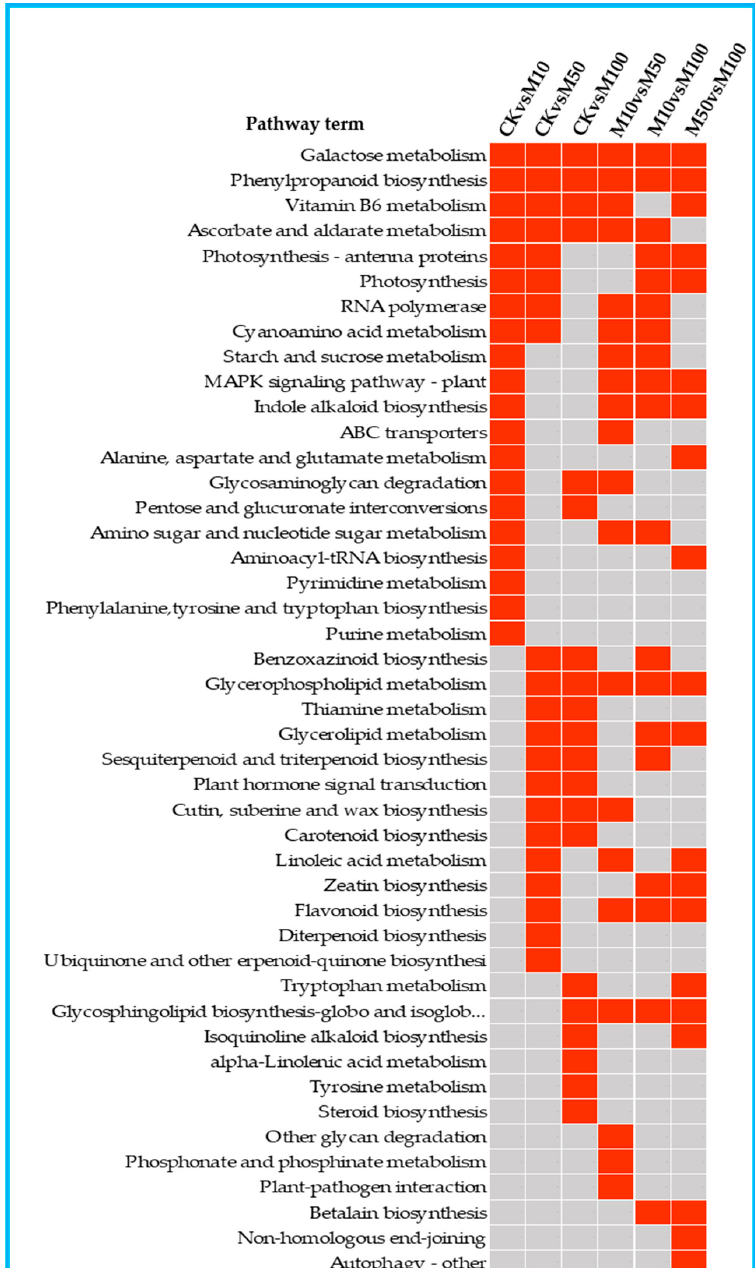
Figure 4. The top 20 KEGG pathways enriched by DEGs in in the comparisons. Red indicates significant enrichment and gray indicates no significant enrichment.